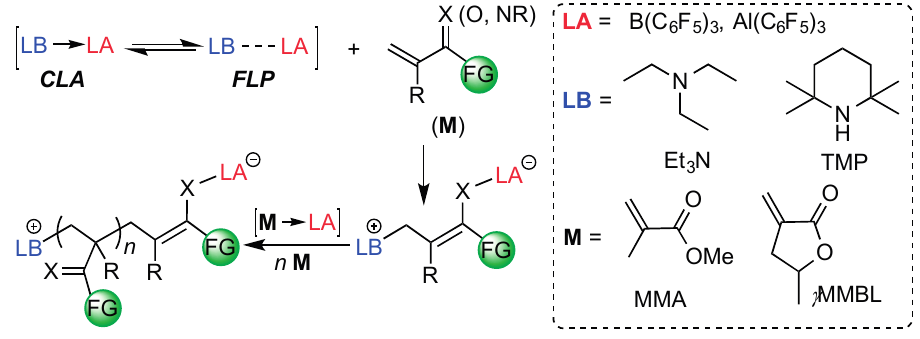
Scheme 1. Generalized chain initiation and propagation mechanism for polymerization of conjugated polar alkenes carrying a functional group (FG) by Lewis pairs through zwitterionic active species or intermediates [56], and the structure of LAs, LBs and monomers examined in this